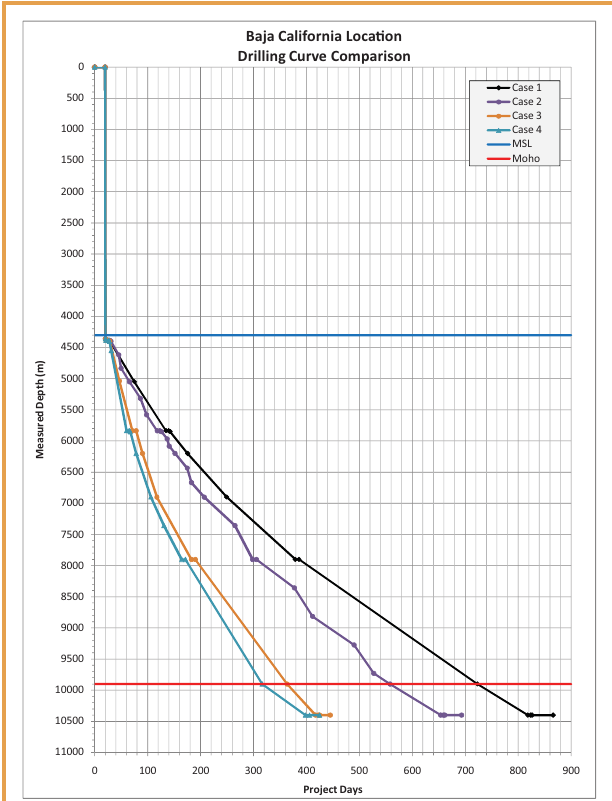
Figure 4. Depth vs. duration of operations. Example for Baja location comparing the four scientific drilling